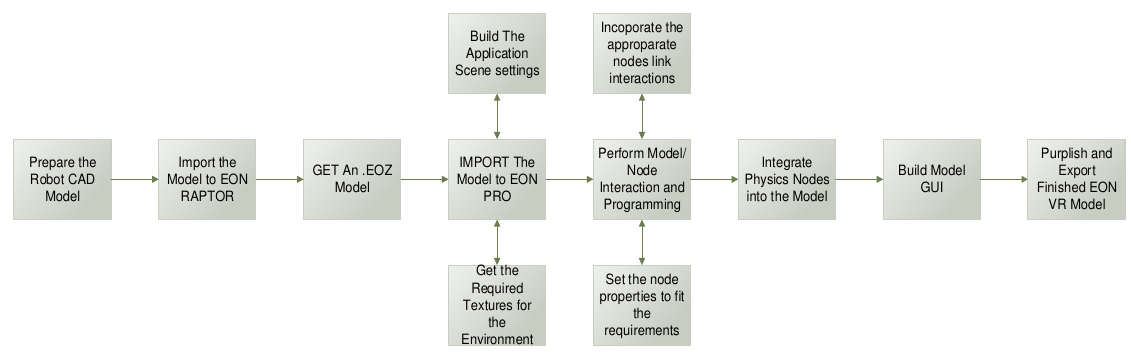
Fig. 4. EON Application Process